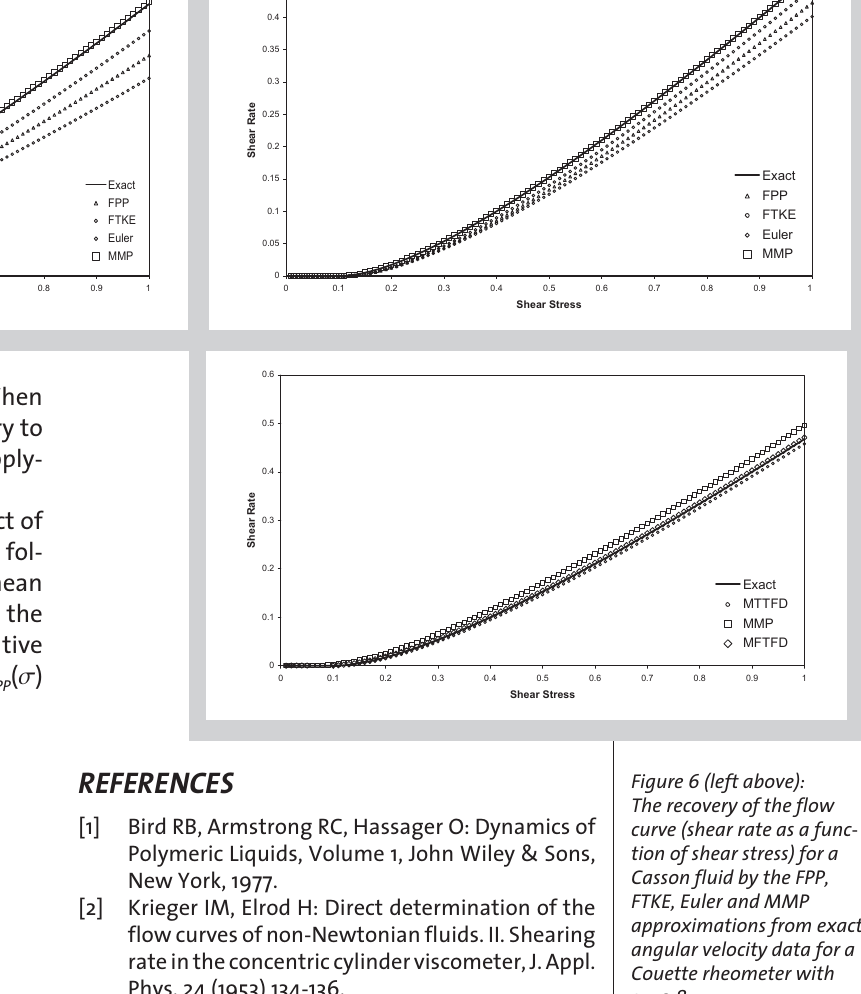
Figure 6 (left above): The recovery of the flow curve (shear rate as a func- tion of shear stress) for a Casson fluid by the FPP, FTKE, Euler and MMP approximations from exact angular velocity data for a Couette rheometer with s = 0.8. Figure 7 (right above): The recovery of the flow curve (shear rate as a func- tion of shear stress) for a Casson fluid by the FPP, FTKE, Euler and MMP approximations from exact angular velocity data for a Couette rheometer with s = 0.9. Figure 8 (below): The recovery of the flow curve (shear rate as a func- tion of shear stress) for a Casson fluid by the MMP, MTTFD and MFTFD approxi- mations from exact angular velocity data for a Couette rheometer with s =